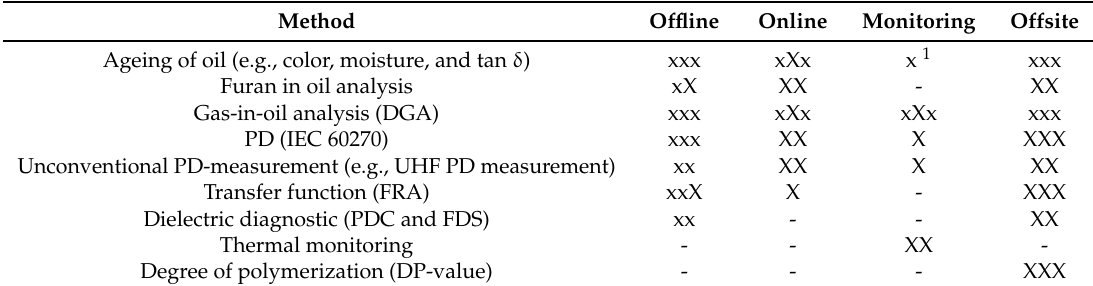
Table 1. Status of different condition assessment techniques. DGA: dissolved gas analysis; PD: partial discharge, IEC: International Electrotechnical Commission, UHF: ultra-high frequency, FRA: frequency response analysis, PDC: polarization and depolarization currents, FDS: frequency domain spectroscopy. Method Offline Online Monitoring Offsite Ageing of oil (e.g., color, moisture, and tan δ ) xxx xXx x 1 xxx Furan in oil analysis xX XX - XX Gas-in-oil analysis (DGA) xxx xXx xXx xxx PD (IEC 60270) xxx XX X XXX Unconventional PD-measurement (e.g., UHF PD measurement) xx XX X XX Transfer function (FRA) xxX X - XXX Dielectric diagnostic (PDC and FDS) xx - - XX Thermal monitoring - - XX - Degree of polymerization (DP-value) - - -